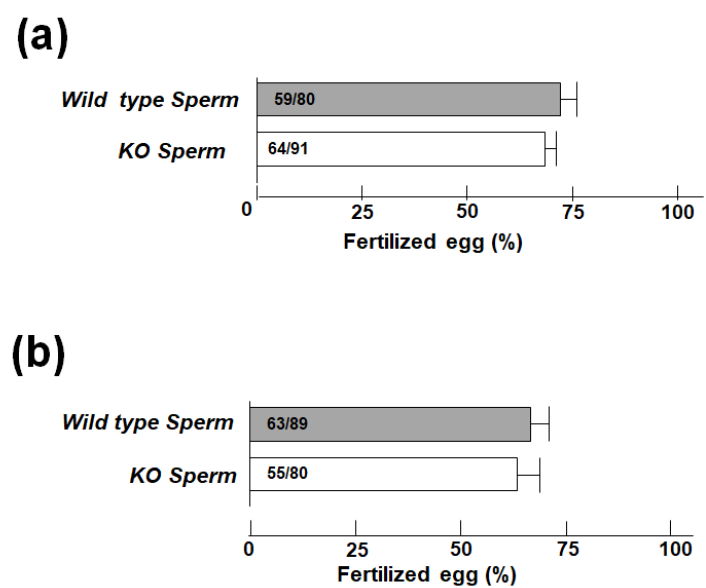
Figure 5. In vitro fertilization (IVF) assay using VSIG1 knockout (KO) mouse sperm. ( a ) The fertilization ratio of intact eggs inseminated with capacitated cauda epididymal sperm from VSIG1 KO and wild-type (WT) male mice. ( b ) Cumulus-free eggs were inseminated with capacitated cauda epididymal sperm derived from WT and VSIG1 KO mice, and the fertilization ratio was determined.